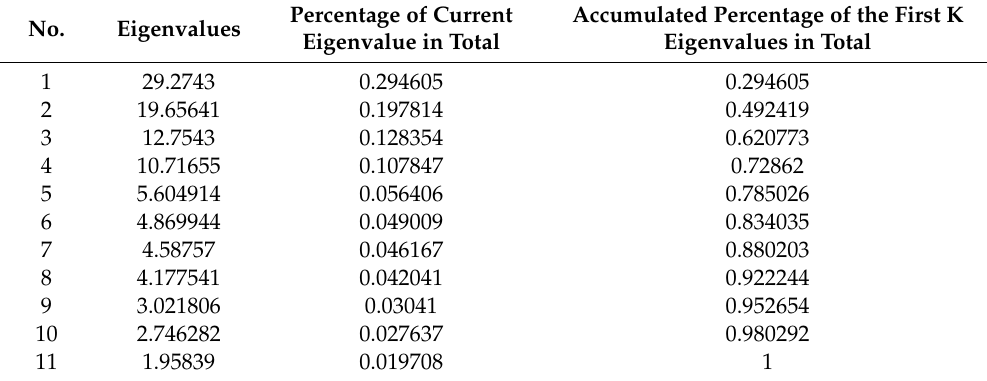
Table 3. Principal component of signal.